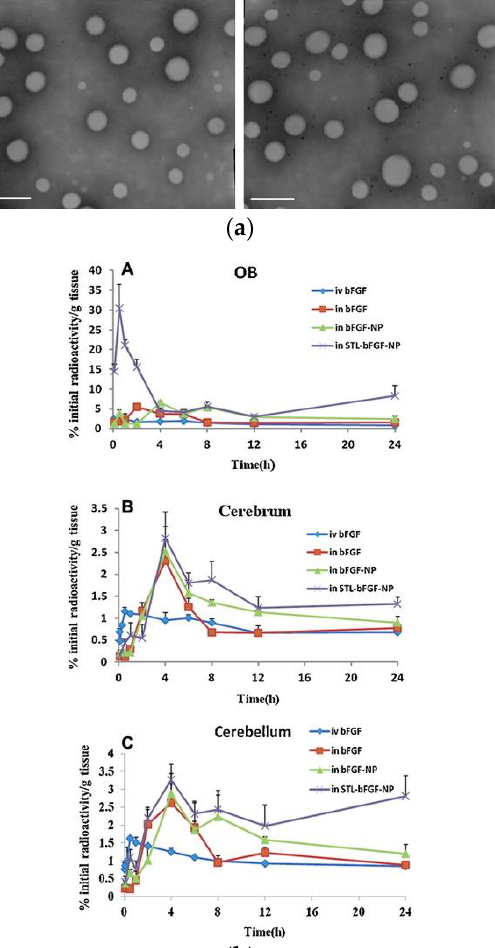
Figure 5. ( a ) The uniform shape of the bFGF-loaded lecithin PEG-PLGA nanoparticles; ( b ) brain distribution of the amount–time profiles of basic fibroblast growth factor in the olfactory bulb: OB (A), cerebrum: CR (B), and cerebellum: CL (C) following the intranasal administration of 125 I-bFGF solution, 125 I-bFGF-NP, and STL- 125 I-bFGF-NP, and an intravenous injection of 125 I-bFGF solution. Reprinted from the International Journal of Pharmaceutics, 461, 11, Zhang et al. Intranasal nanoparti- cles of basic fibroblast growth factor for brain delivery to treat Alzheimer’s disease, copyright (2014), with permission from Elsevier